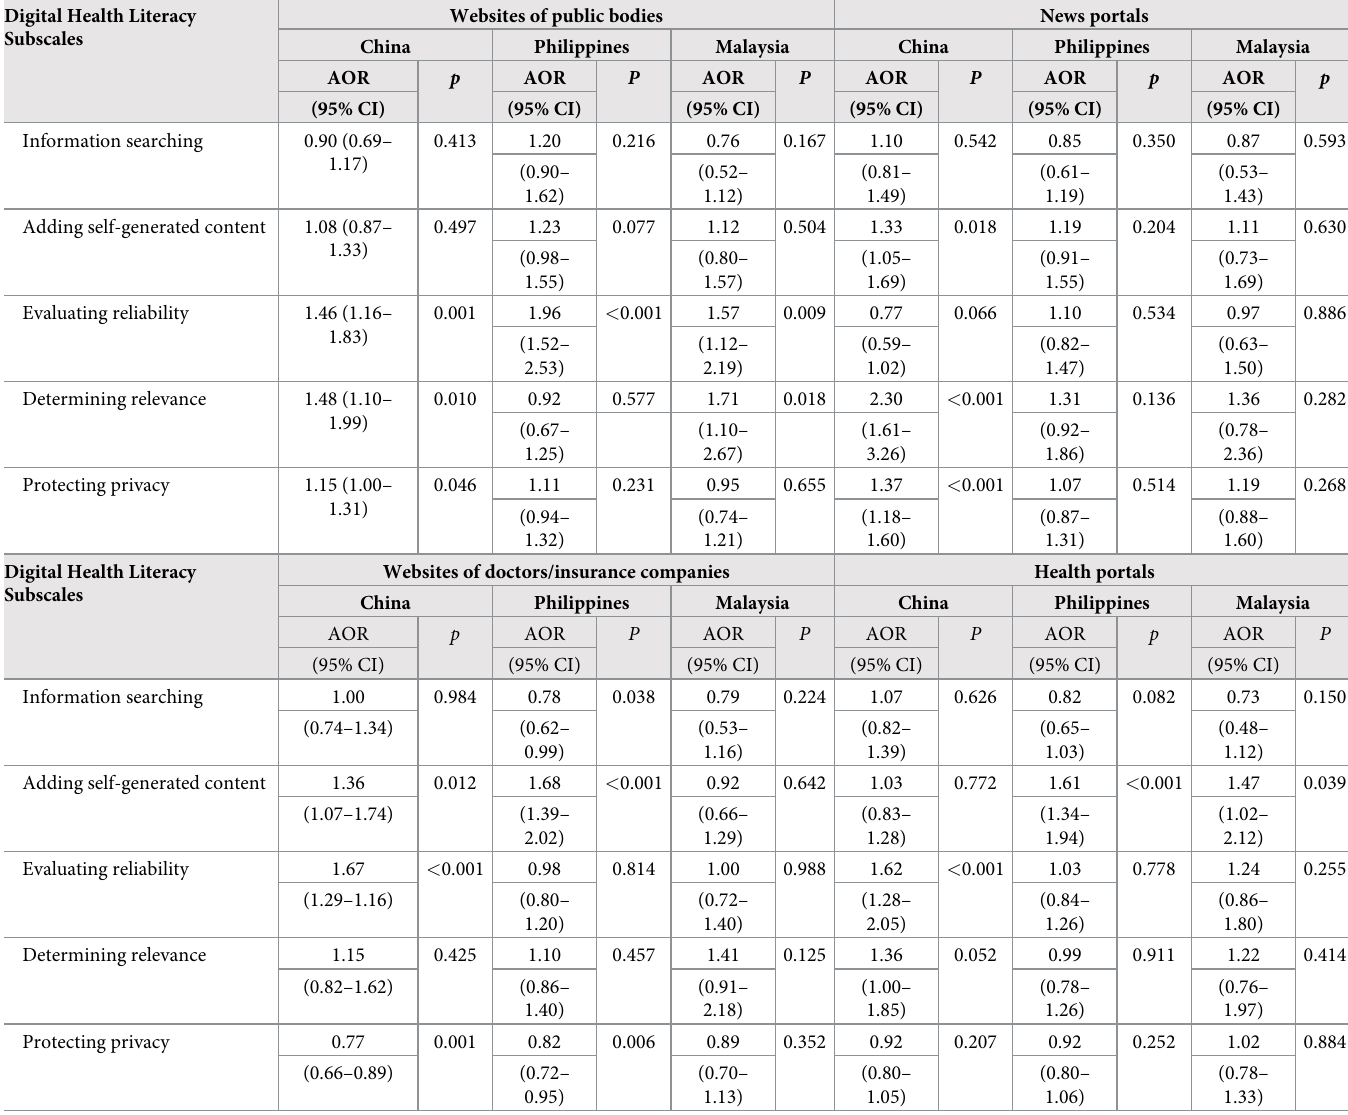
Table 3. Association between DHL and utilization of trustworthy information sources among university students from China, Malaysia, and the Philippines (n =